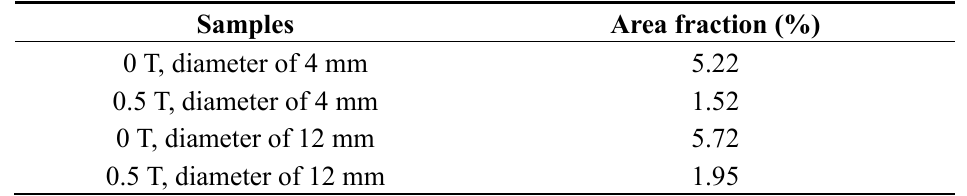
Table 1. Influence of magnetic field on eutectic formation of directionally